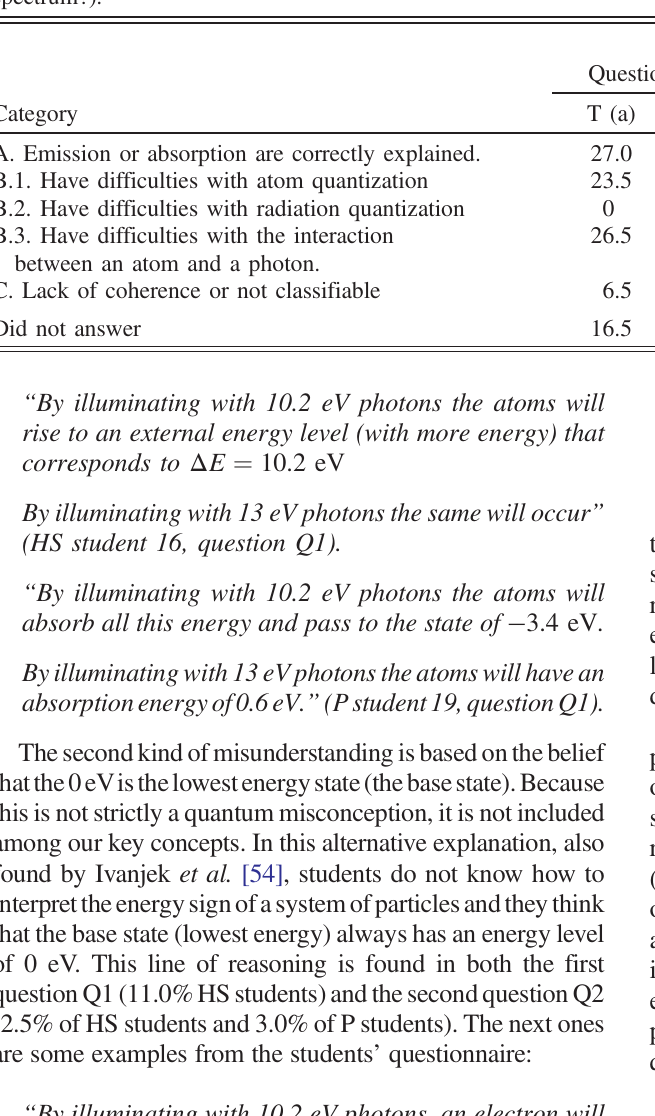
TABLE II. Percentage of answers given to the questions by 30 teachers (T). The question Q1 for teachers has two parts concerning the atom (part a: What will happen to the gas atoms?) and concerning the radiation (part b: What will we observe if we obtain the light